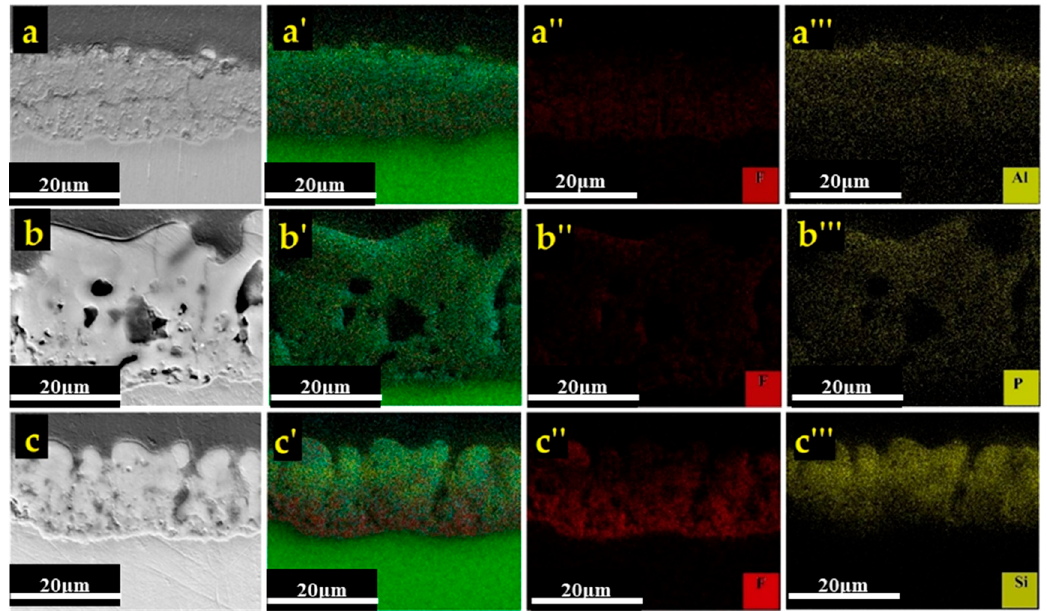
Figure 5. Elemental distribution over PEO coatings cross-sections marked by green, blue, red, and yellow colors for magnesium, oxygen, fluorine, and electrolyte elements (Al, P, Si), respectively; ( a , a’ , a’’ , a’’’ ) for Al, ( b , b’ , b’’ , b’’’ ) for Ph, and ( c , c’ , c’’ , c’’’ ) for Si.